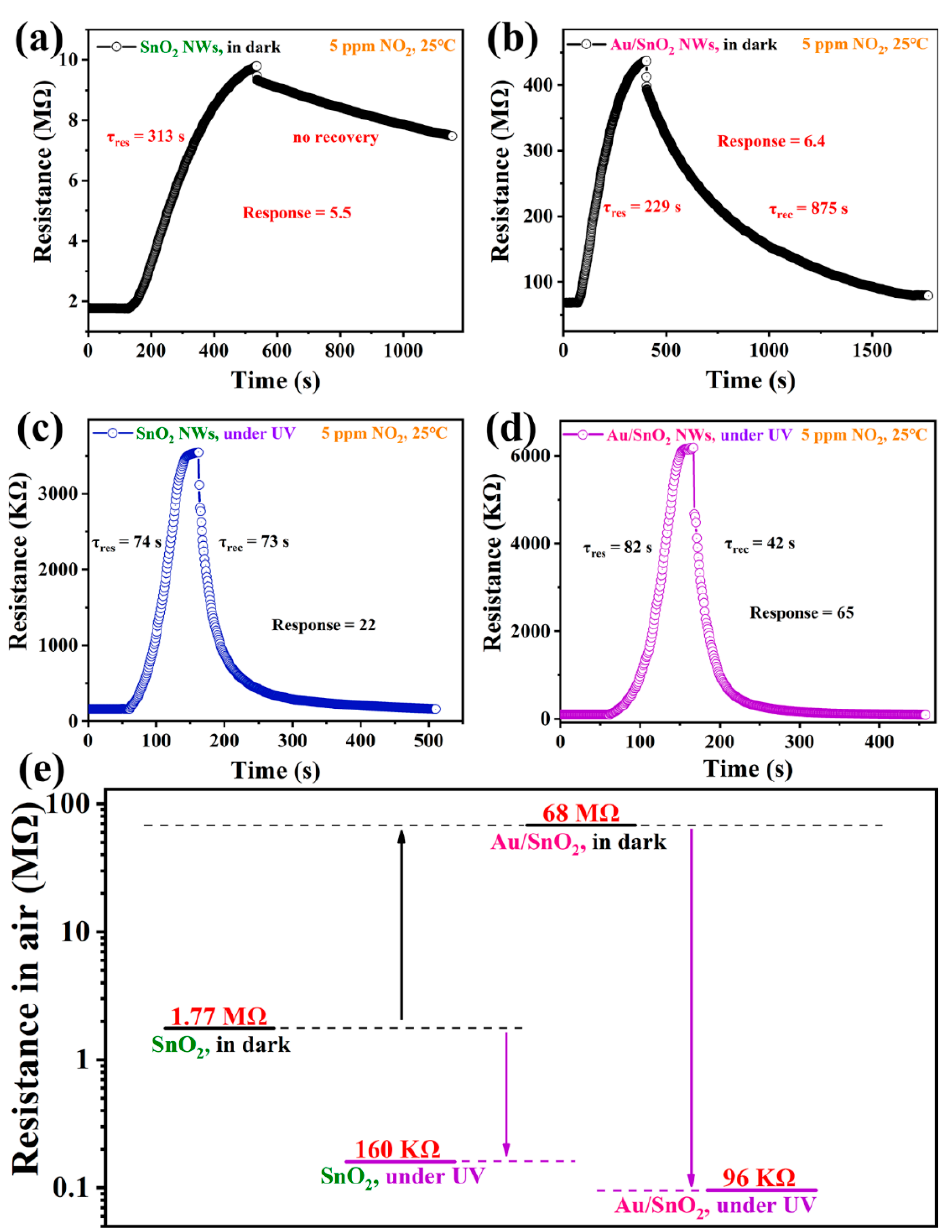
Figure 6. Single-cycle response–recovery transient curves of the sensor based on SnO 2 NWs toward 5 ppm NO 2 at RT ( a ) in the dark and ( c ) under UV irradiation (0.42 mW/cm 2 ). Single-cycle response– recovery transient curves of the sensor based on Au/SnO 2 NWs toward 5 ppm NO 2 at RT ( b ) in the dark and ( d ) under UV irradiation (0.42 mW/cm 2 ). ( e ) The dynamically stable resistance values in the air of sensors based on SnO 2 and Au/SnO 2 NWs in the dark and under UV irradiation (0.42 mW/cm 2